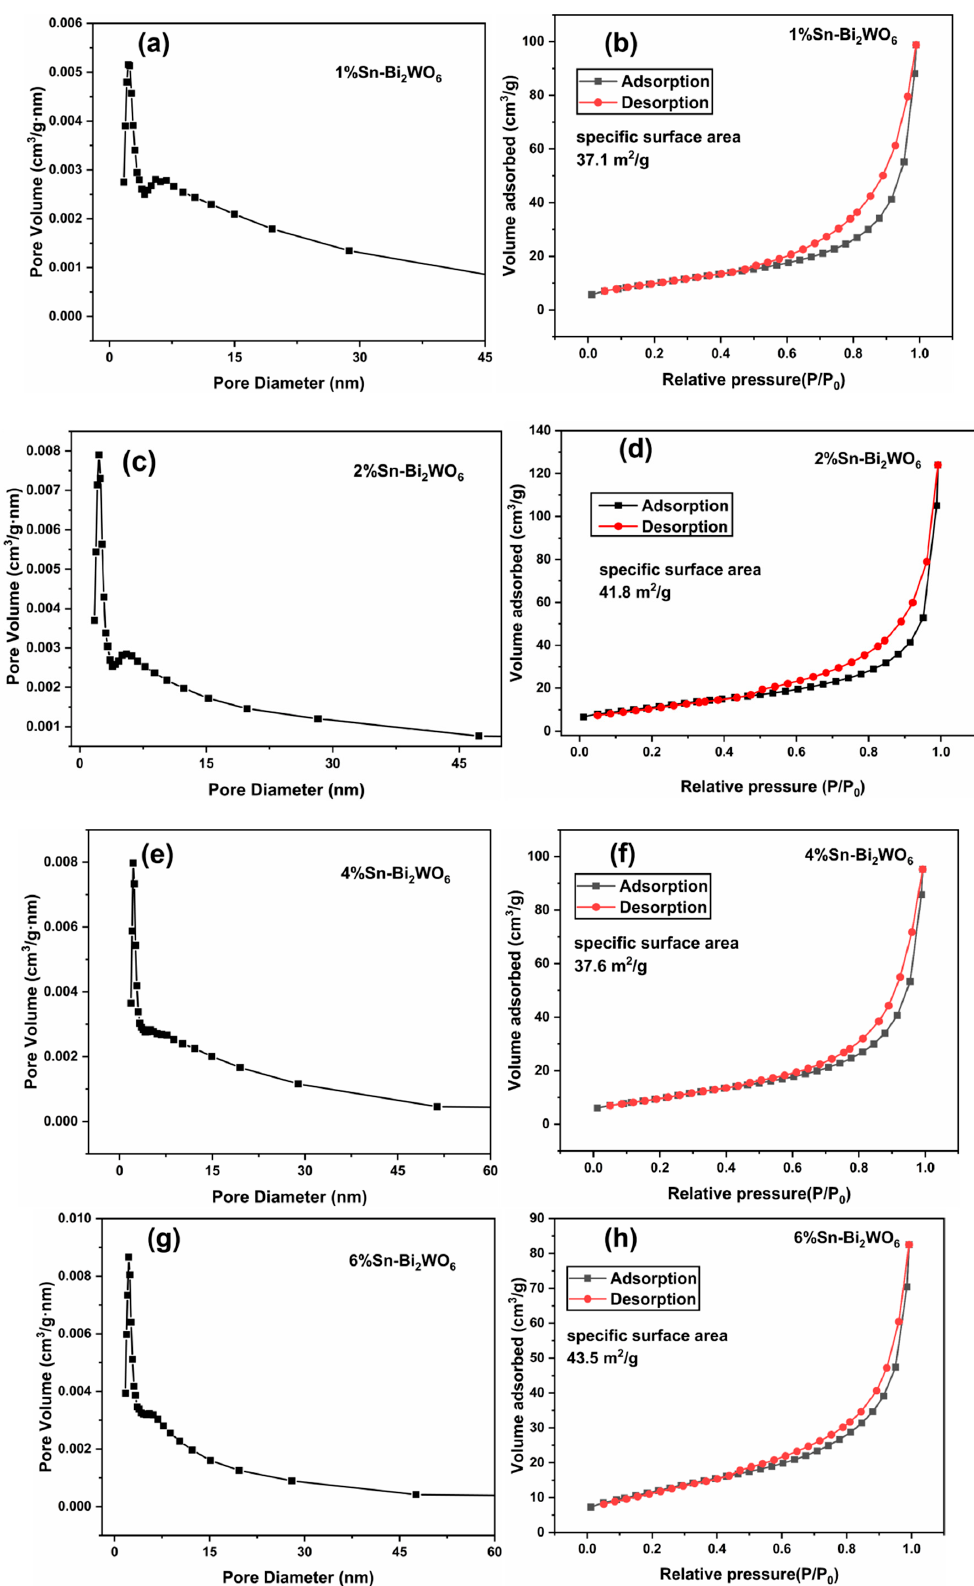
Figure 4. Pore size distribution curves and N 2 adsorption–desorption isotherms of 1%Sn-Bi 2 WO